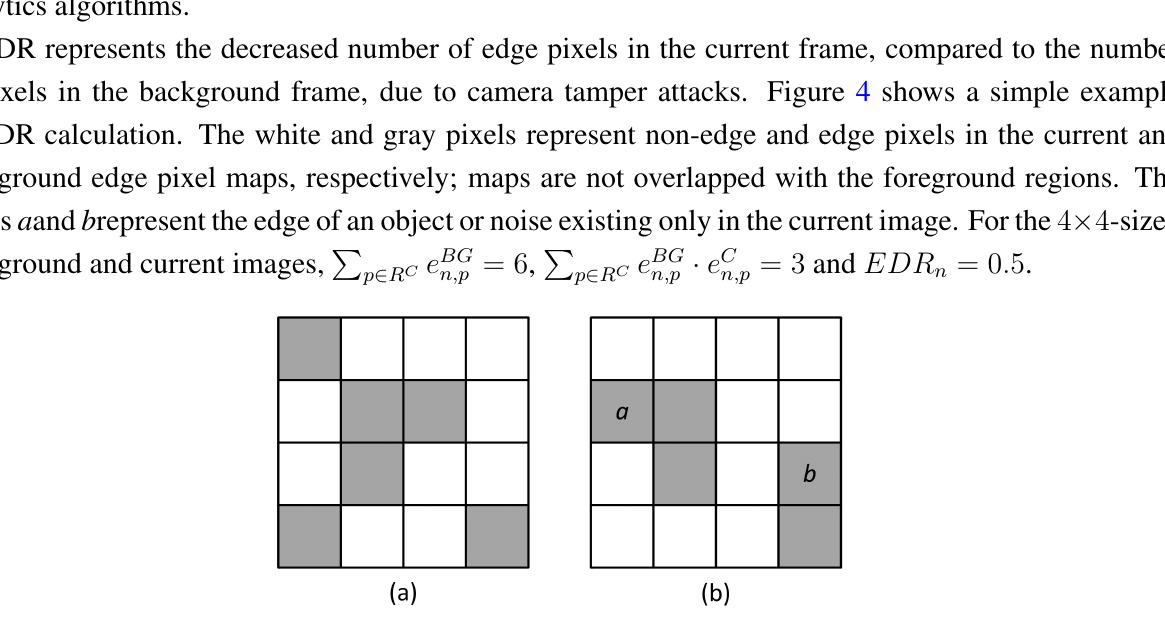
Figure 4. An example image for edge disappearance rate (EDR) calculation: ( a ) background edge image; ( b ) current edge